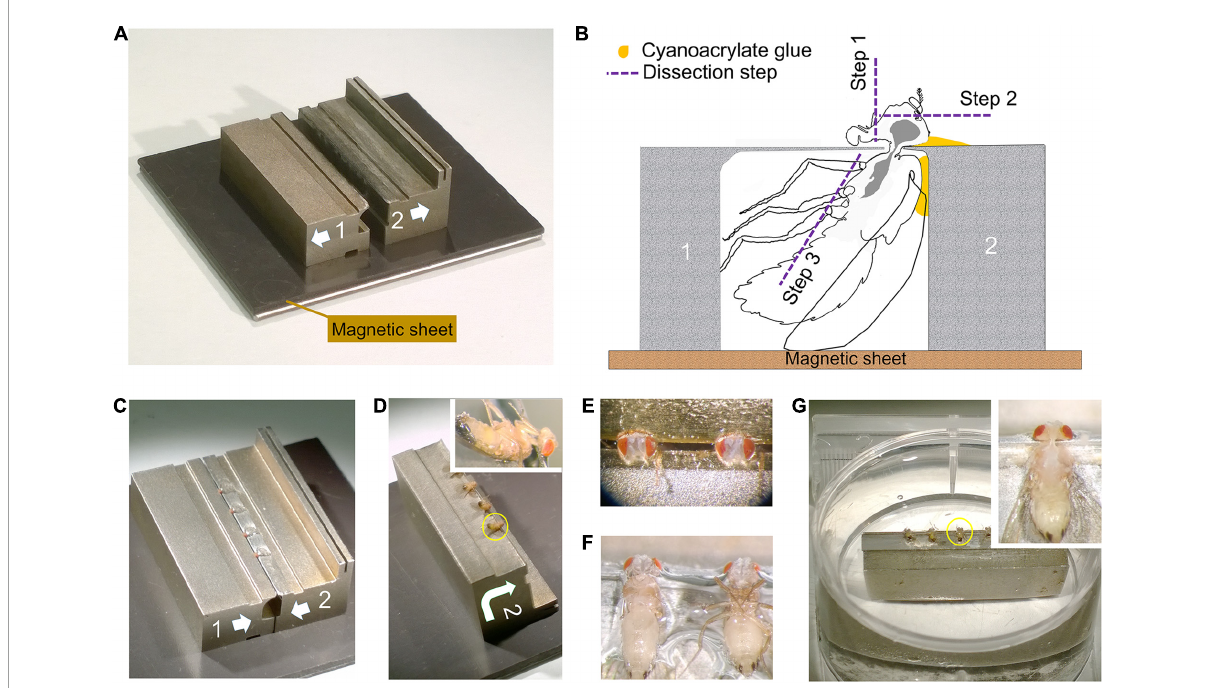
FIGURE3 Dissection collar modified for dissecting the entire CNS (see Supplementary Video 1 ). (A) Two half stocks (1 and 2) arranged to form a pillory on a magnetic base for quick assembly. Quick release shown as arrows on each stock (also in C,D ). Stock 2 has an elevated bar for forceps to grip and transfer the stock. (B) Outline of fly in a dissection pillory, held captive at its neck by thin metal shim, to show the position of Loctite glue and dissection steps 1–3. (C) Four flies with protruding heads, loaded and glued into assembled pillory as in (B) . (D) Stock 2 separated from its partner stock 1 and turned over, with flies glued by the cuticle of their dorsal thorax as in (B) . Inset: Enlarged view of one fly. (E) Two heads in saline after dissection step 1 and 2 in (B) to remove the proboscis and frontal head cuticle together with antennae. (F) Showing the pinioned flies turned over from (E) and transferred to saline, with left-side legs removed as in step 3 in (B) . (G) The pinioned flies on stock 2 in saline or PB buffer in tissue culture dish. Inset: Single fly with legs and abdominal cuticle removed to expose the entire CNS (brain and VNC) as shown in the yellow circle in (G) .